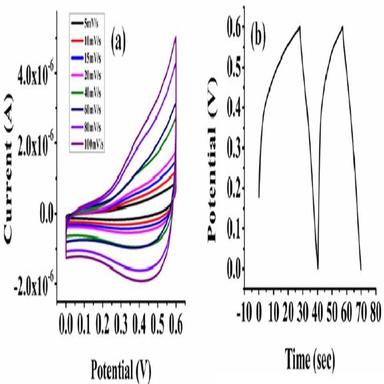
(a) Cyclic voltammetry (CV) curves at different scan rate and (b) galvanostatic charge/discharge curve for drop casted nanocomposite A(NC) on (GCE) with reference to Ag/AgCl electrode in 1 M Na2SO4.